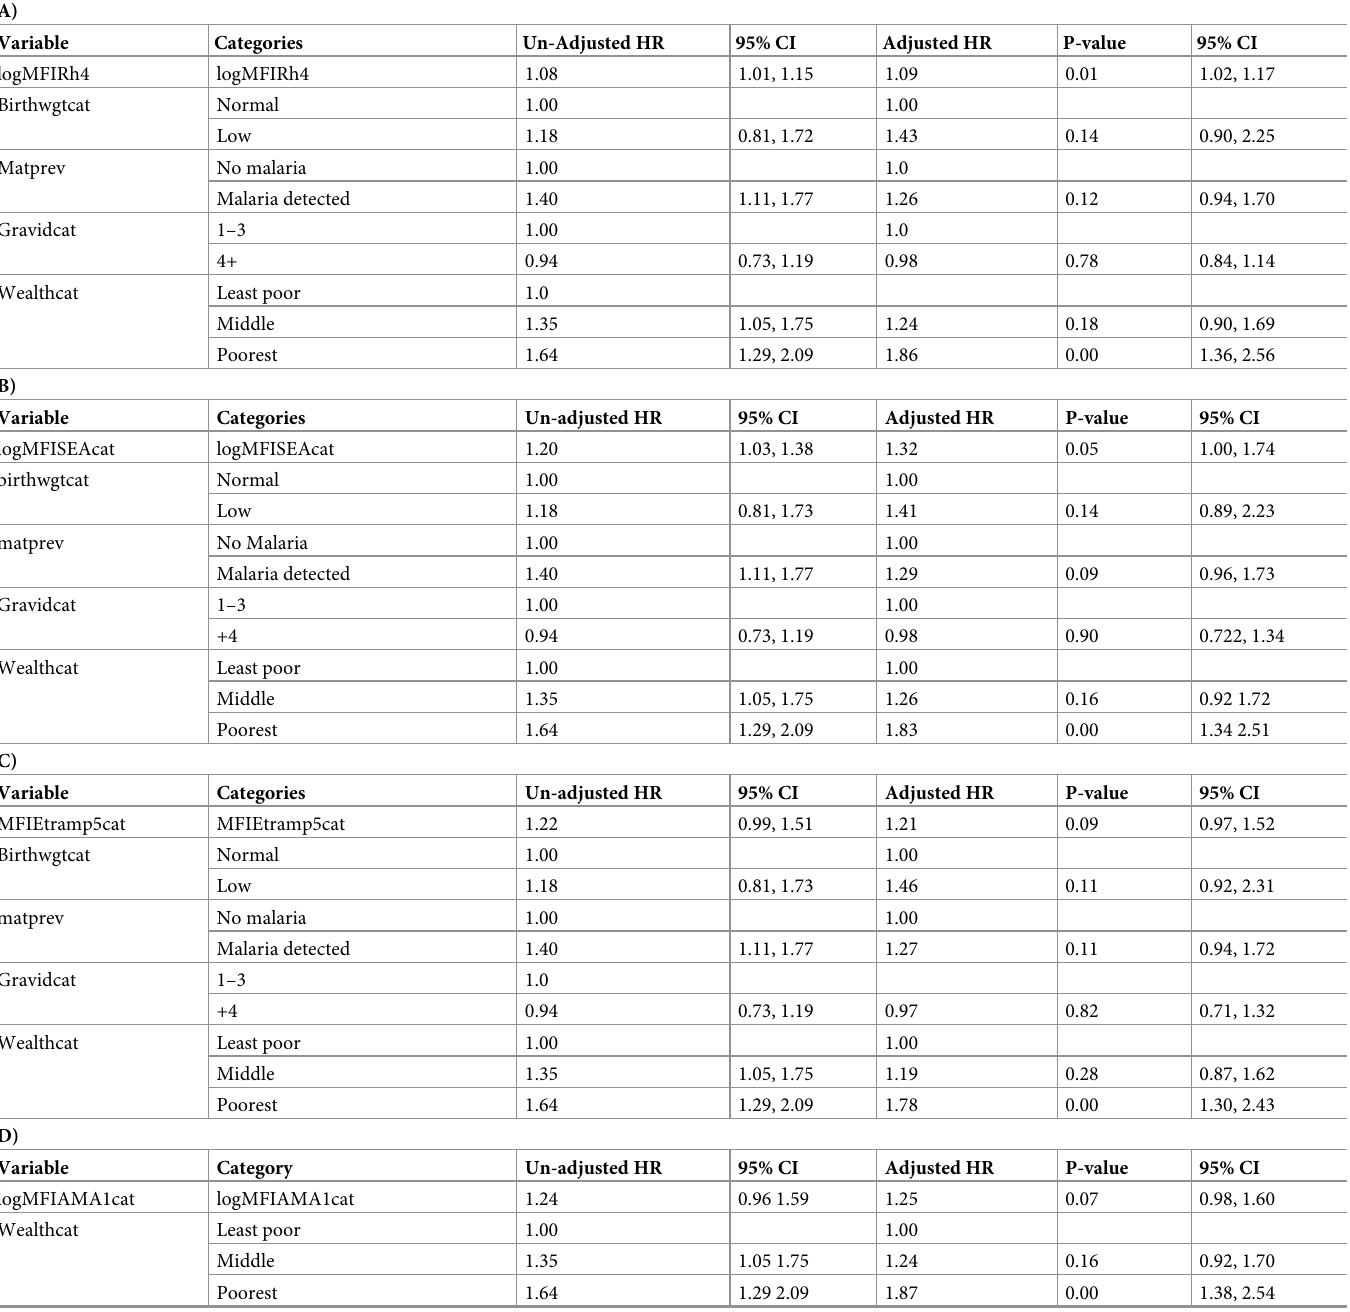
Table 4. Cox regression model of effects of increased levels of expression of total IgG against Rh4.2 adjusted for selected non-IgG covariates on risk of malaria infec- tions in the first birth year. A. B. Cox regression model of effects of increased levels of expression of total IgG against PfSEA adjusted for selected non-IgG covariates on risk of malaria infections in the first birth year. C. Cox regression model of effects of increased levels of expression of total IgG against Etramp5Ag1 adjusted for non-IgG covariates on risk of malaria infections in the first birth year. D. Cox regression model of effects of increased levels of expression of total IgG against AMA, adjusted for maternal wealth category index on risk of malaria infections in the first birth year. E. Cox regression models of effects of increased levels of expression of total IgG against EBA175, adjusted for non-IgG covariates on risk of malaria infections in the first birth year. F. Cox regression model of effects of increased levels of expression of total IgG against GLURP181 adjusted for non-IgG covariates on risk of malaria infections in the first birth